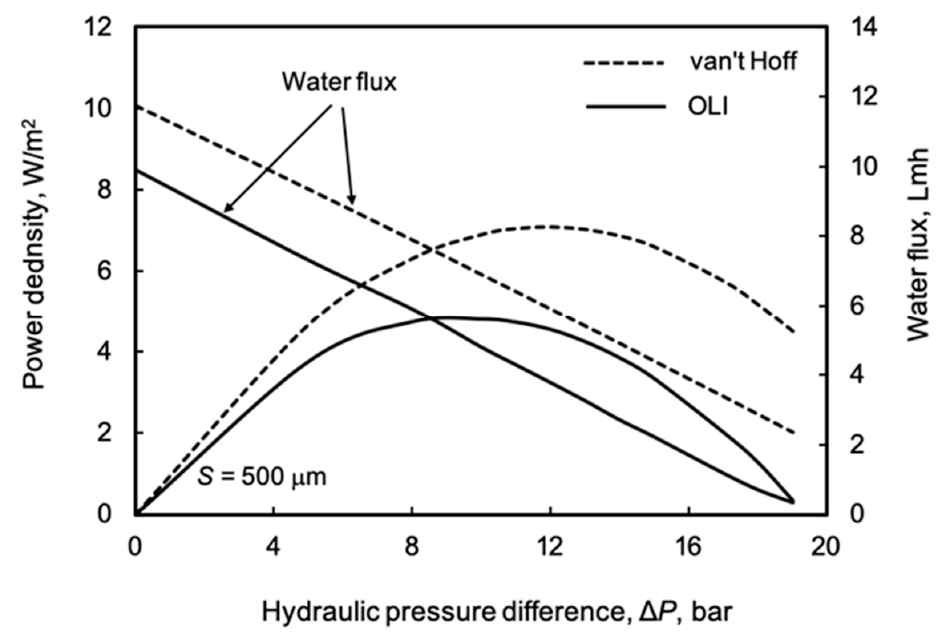
Figure 6. Power density/water flux as a function of the hydraulic pressure difference applying the van ’t Hoff approach and the OLI software for prediction of the osmotic pressure (other parameters are listed in Table 2).